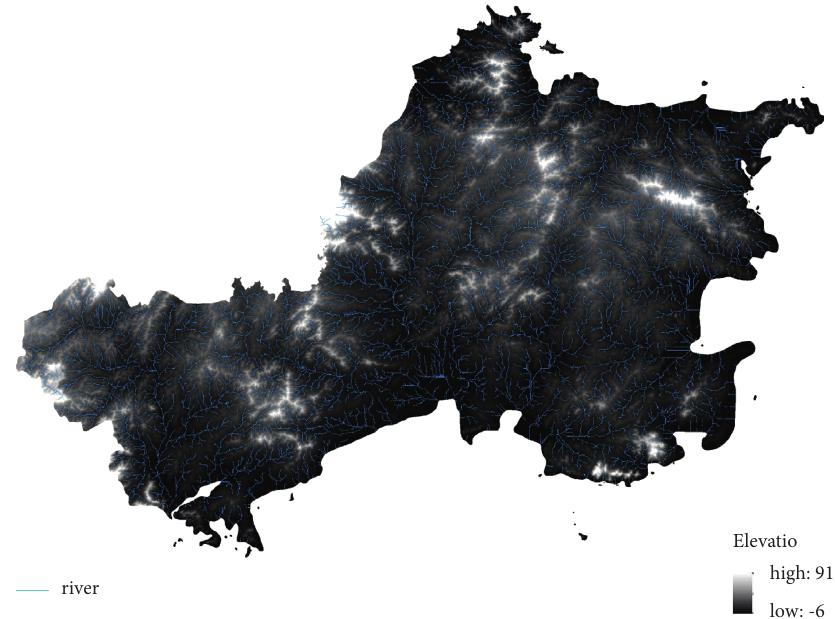
Figure 4: DEM waterline simulation in Weihai.